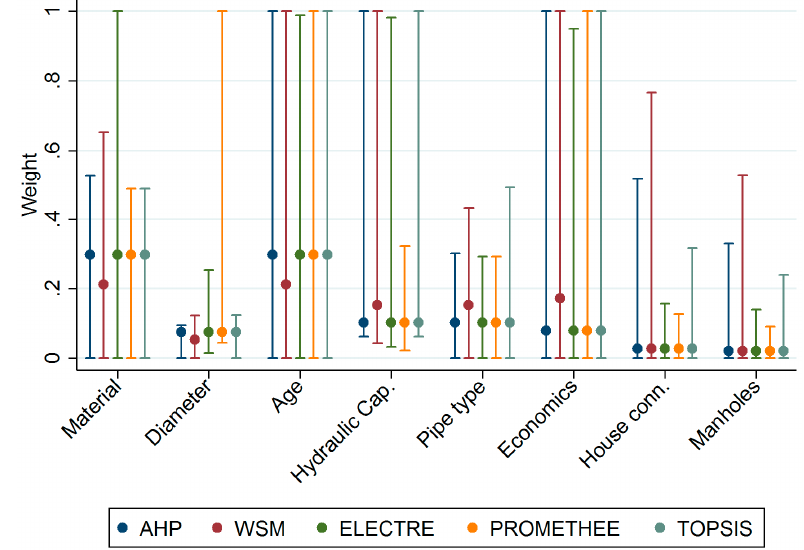
Figure 8. Sensitivity analysis for the sewer network.